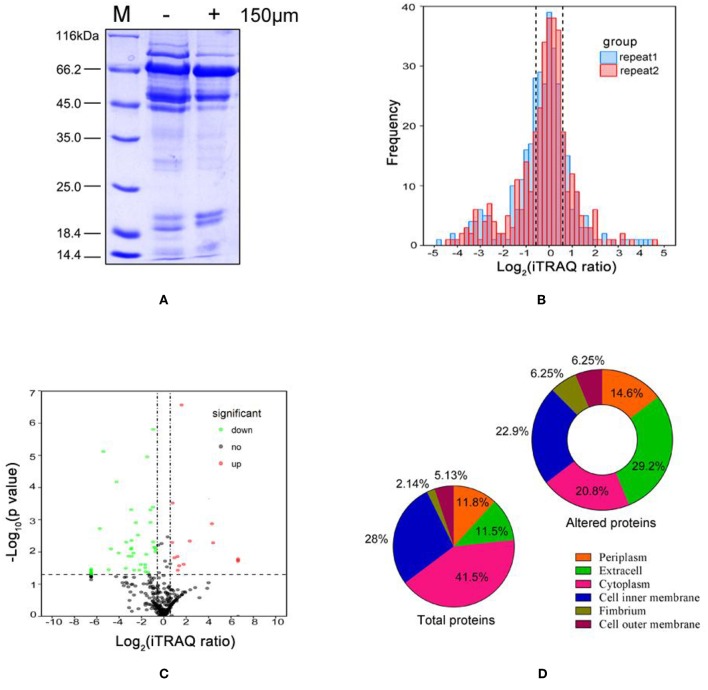
Characteristics of Aeromonas hydrophila LP-2 grown in iron-limited conditions. (A) Coomassie brilliant blue(CBB) stained SDS-PAGE of extracelluar protein fractions from A. hydrophila treated with 150 μM DIP. Lane M, molecular mass standards. (B) The frequency distribution of protein iTRAQ log2 ratios between the two biological replicates. (C) Volcano plot comparing the extracellular proteomics of A. hydrophila grown in iron-limited conditions and A. hydrophila grown in normal conditions. Solid lines indicate statistically significant differences in protein expression (iTRAQ ratio >1.5 or <0.66 and p < 0.05 for both biological replicates). Upregulated proteins are indicated by red circles; downregulated proteins are indicated by green circles; and unaltered proteins are indicated by black circles. (D) Subcellular locations predicted for all identified proteins and for all differentially expressed proteins.